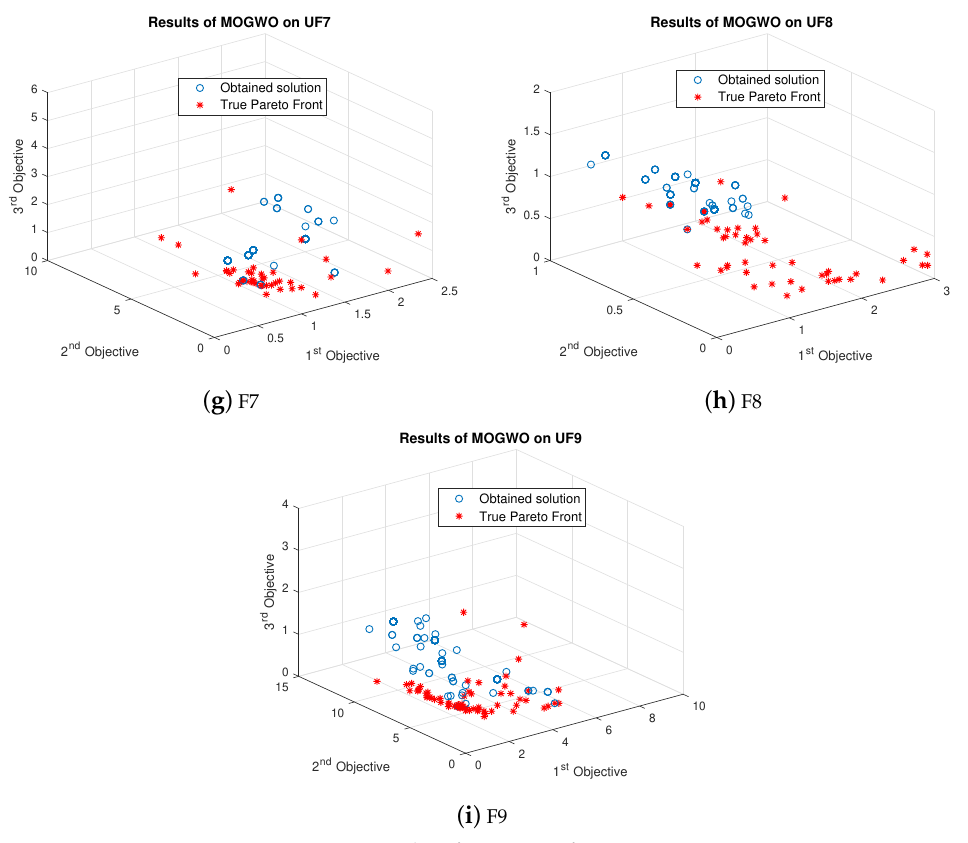
Figure 10. Results of MOGWO for Scenario